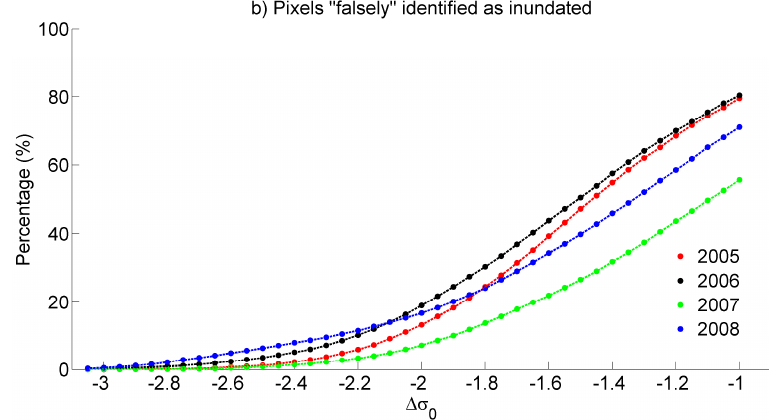
Figure 8. Percentage of pixels detected as inundated ( a ) and falsely identified as inundated during the rainy seasons (December–June) from 2005 to 2008 as a function of the normalized anomaly of backscattering though comparison with the SWR from DFO in the Guayas floodplain ( b ).